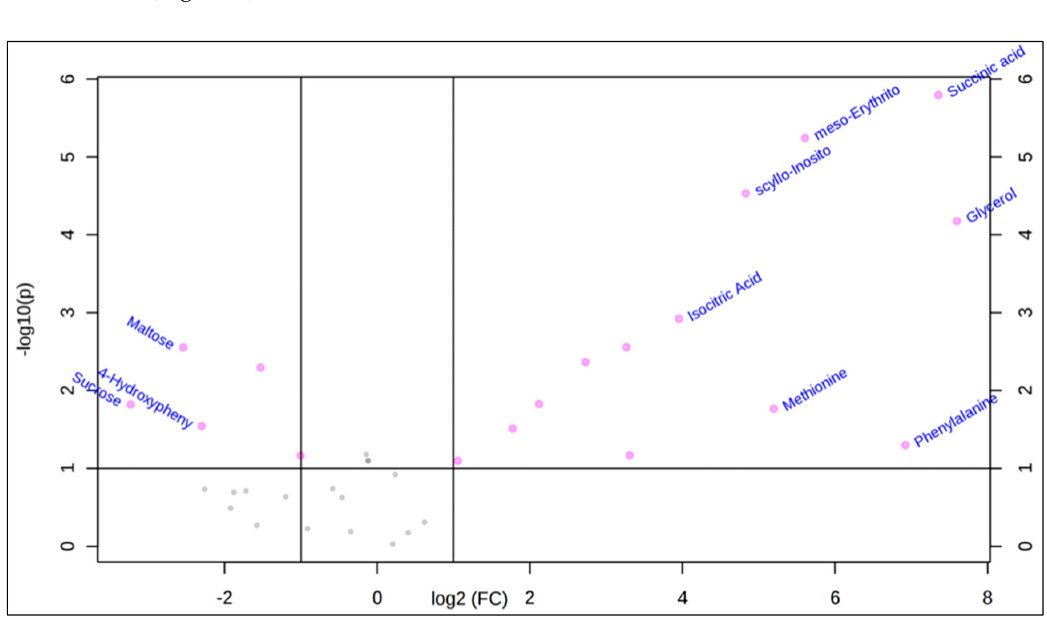
Figure 1. Univariate volcano plot analysis with fold change threshold (x) 2 and t-tests threshold (y) 0.1 showing metabolites with significantly different abundance between D. caninum ESP and culture medium. The further the metabolite position is from (0,0), the more significant the difference in metabolite presence (pink dots). Data analyzed by MetaboAnalyst 4 (samples normalized by mean, log transformation and autoscaling).